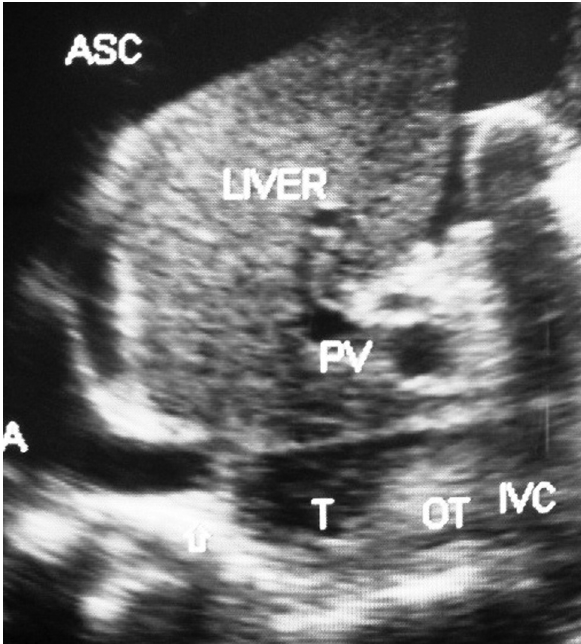
Figure 3. Hepatic vena cava syndrome: Ultrasonography of a young patient with ascites showing localized stenosis of upper segment of IVC with distal dilated segment of the IVC fi lled with recent and old organized thrombi. ASC, ascites; IVC, inferior vena cava; OT, organized thrombus; RA, right atrium; T, thrombus. (Copyright: Santosh Man Shrestha).